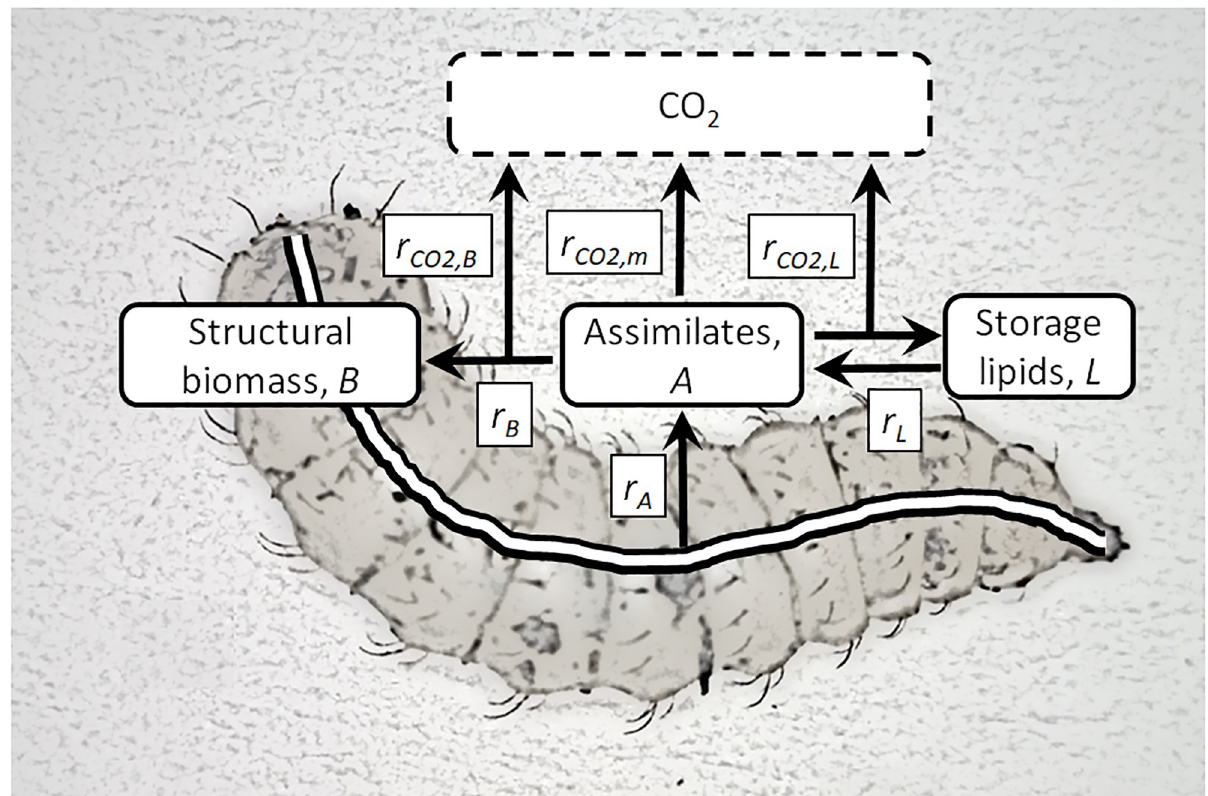
Fig 1. Differential energy budget model of BSF larva. Larval biomass is compartmentised into structural biomass, B , storage lipids, L , and a pool of assimilates, A . Feed components are assimilated (from the intestine) into the pool of assimilates at rate, r A from where they are metabolized to CO 2 to generate energy for maintenance at rate r to generate energy for the synthesis of structural biomass or storage lipids at rates r